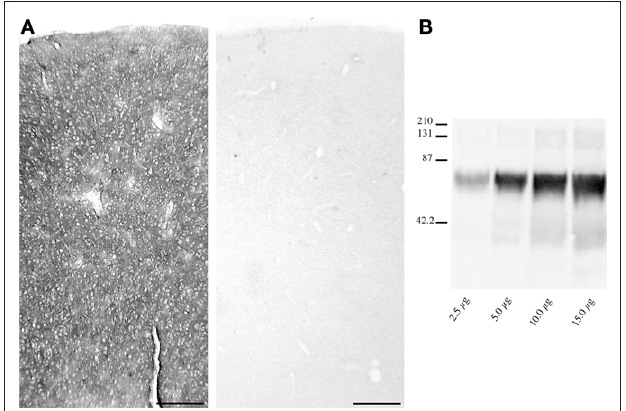
FiGurE 2 | Method specificity. (A) EAAT2a-ir in human cortex (area 46, HBC 961102; left ) is completely abolished ( right ) by preincubation of EAAT2a antibodies with 10 − 3 M of EAAT2a synthetic peptide. (B) Western 559–573 blottings of cortical synaptic membranes (area 7, HBC 040925) shows that EAAT2a antibodies recognize a band of ∼ 70 kDa among a wide range of total protein loaded (from 2.5 to 15.0 μg/lane). Scale bar: 200 μm for (A)